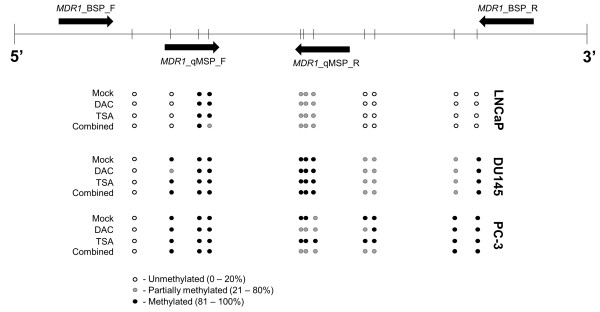
Characterization of the methylation status of individual CpG dinucleotides by bisulfite sequencing. The upper panel of the diagram represents the region of the gene under analysis, bisulfite sequence (BSP) and quantitative MSP (qMSP) primers (black arrows) and CpG dinucleotides density (vertical bars). The lower panel shows the status of methylation for each CpG dinucleotide for three different PCa cell lines (LNCaP, DU145 and PC3) exposed to epigenetic drugs. White circle – unmethylated CpG (0–0.20); grey circle – partially methylated CpG (0.21 - 0.80); black circle – fully methylated CpG (0.81 - 1.0).